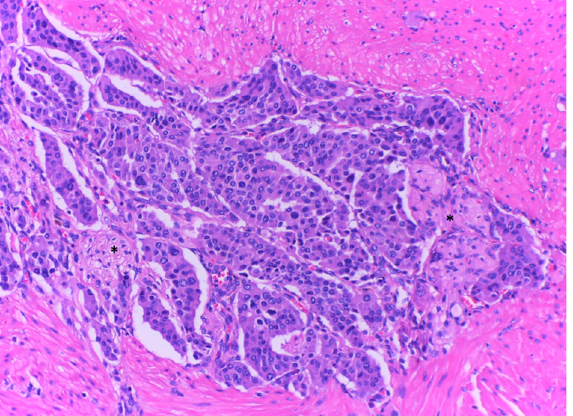
Figure 7. Immunohistochemical staining tumor cells of NEN are positive (stained brown) for Synapthophysin. On the left one can see the duodenal glands that are negative, × 100.